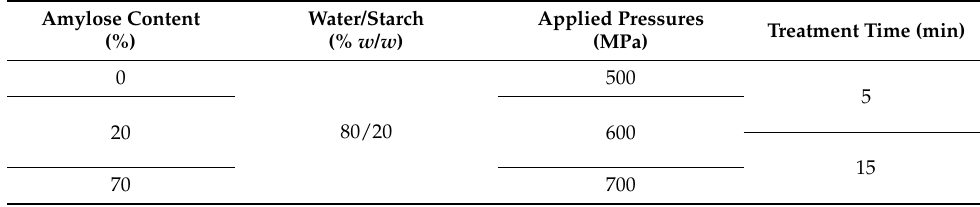
Table 1. Samples formulation and HPP treatment conditions used in the